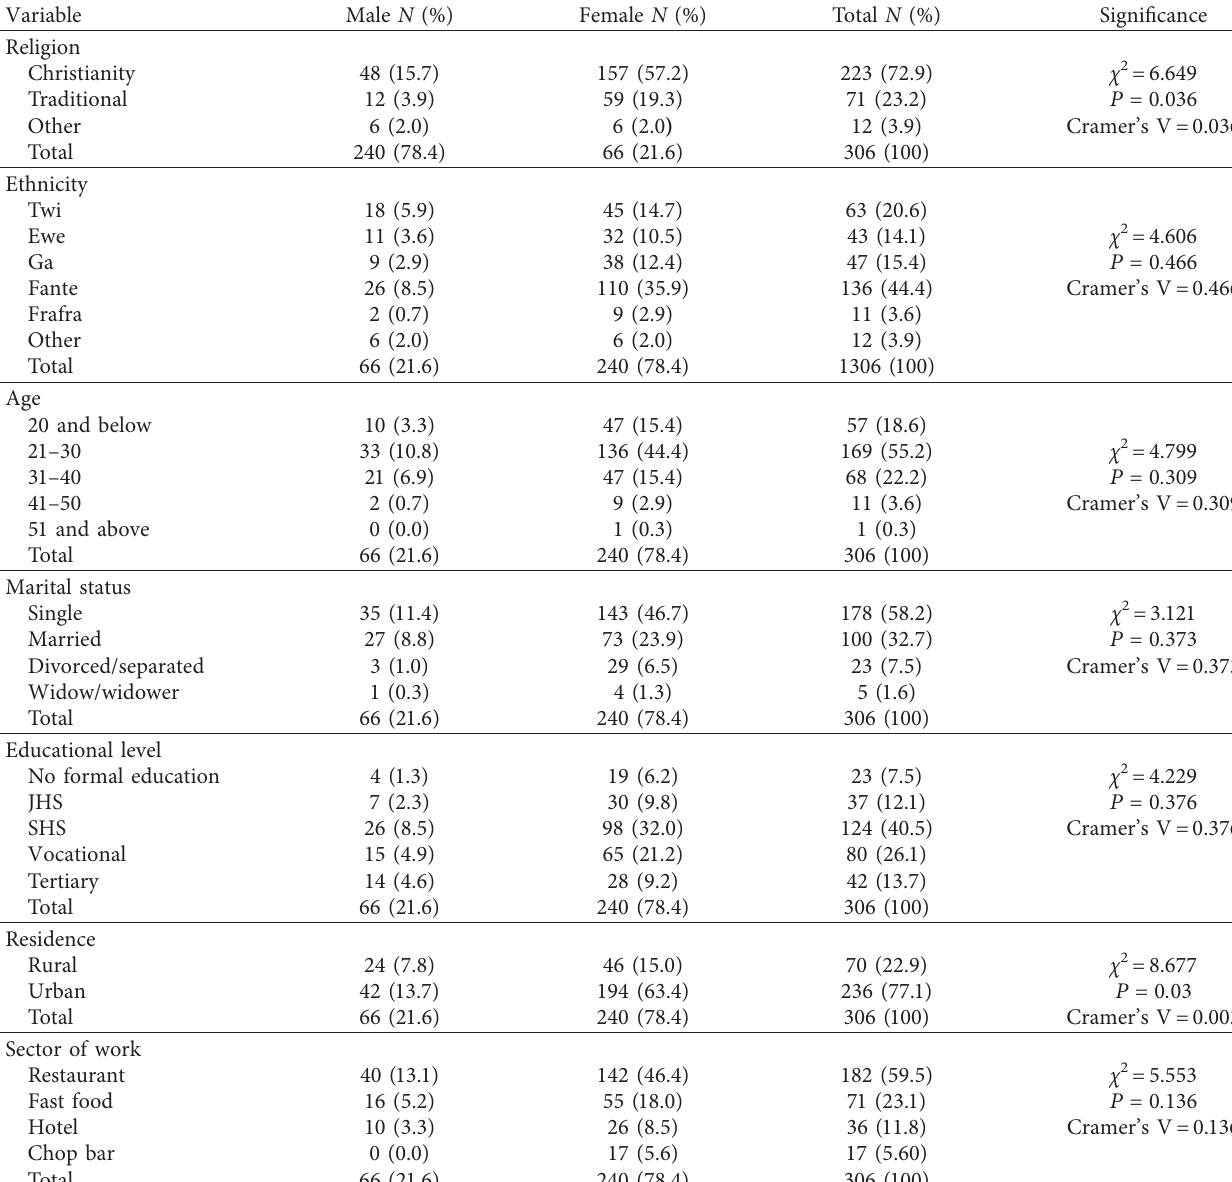
Table 1: Demographic characteristics of the respondents.